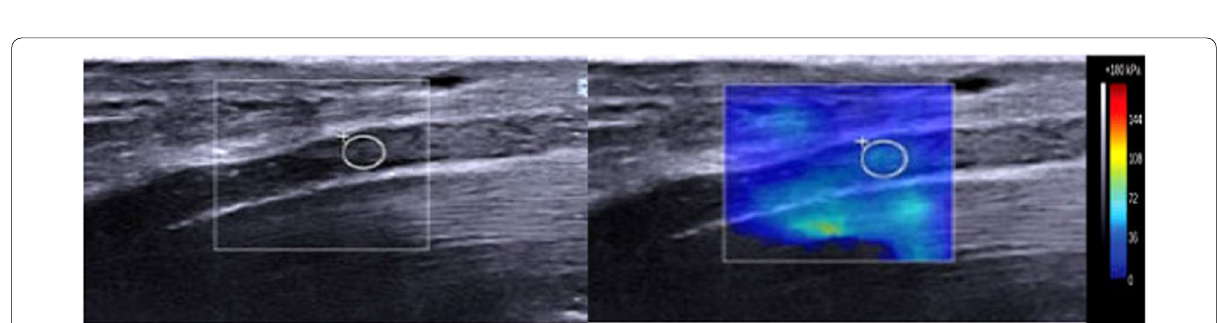
Fig. 4 A 54 years old female patient with clinical evidence of DPN. (Left) high resolution ultrasound showed thickened tibial nerve with increased CSA (16.3 mm 2 ). (Right) shear-wave elastography of the tibial nerve displayed increased mean tibial nerve stiffness value